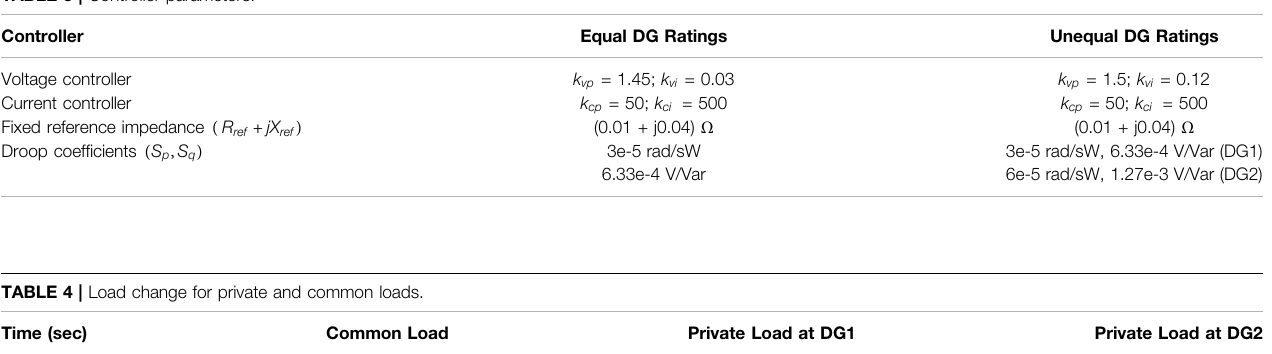
TABLE 3 | Controller parameters.